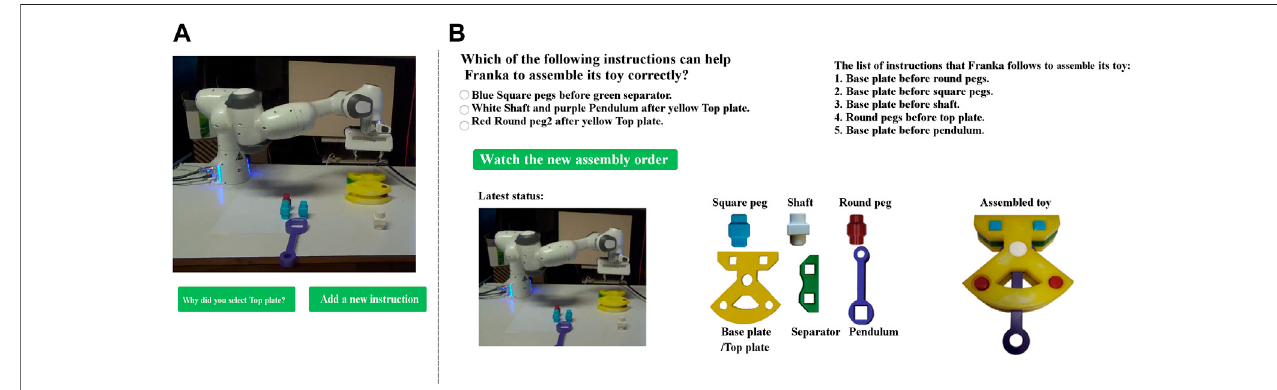
FIGURE3| Ifthecobotstopstheassemblytaskwhilesomeobjectsremainunassembled (A) ,theusercanclickon “ Addanewinstruction ” buttonwhichleadstoa newwindow (B) ,whereanewinstructioncanbetaught.Inthenewwindow (B) ,theusercanseethelateststatusoftheassemblytask,thenameofdifferentobjects,the correctly assembled form of the Cran fi eld benchmark, and three instructions from which the user can teach one to the cobot (only one instruction is correct). Each instruction provides information about the correct assembly order of two objects, e.g., yellow base Plate before red Round peg. It is worth mentioning that this interface is the same for both B-GUI and T-GUI (Section 4)